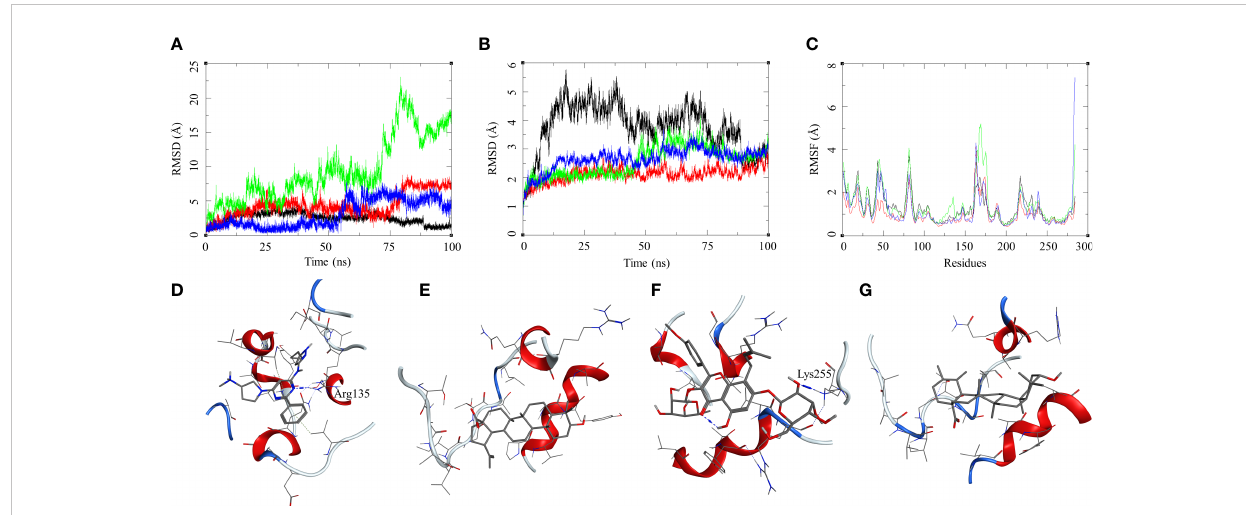
FIGURE 7 Molecular dynamics simulation results for M. tuberculosis serine/threonine-protein kinase (STPK) (PDB: 1MRU) complexes: (A) ligand RMSD for MRCT67127 (black), BA (red), IC (green), and UA (blue); (B) ligand-bound protein RMSD for MRCT67127 (black), BA (red), IC (green), and UA (blue); (C) ligand-bound protein RMSF for MRCT67127 (black), BA (red), IC (green), and UA (blue). Protein – ligand complex poses at the end of the 100-ns simulations, (D) STPK – MRCT67127, (E) STPK – BA, (F) STPK – IC, and (G) STPK –